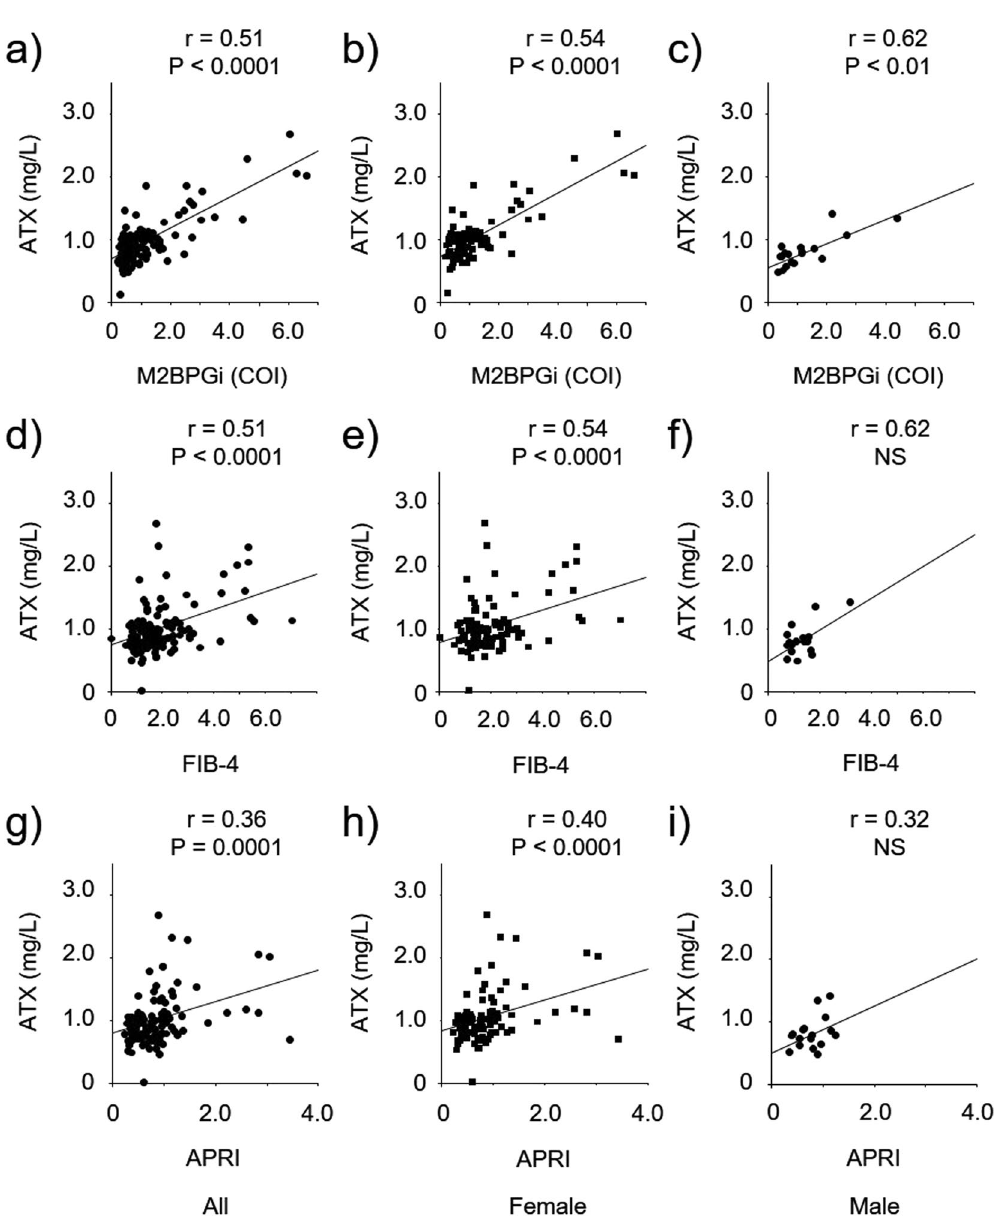
Figure 2. Correlation between ATX and other fibrosis markers, such as M2BPGi ( a – c ), FIB-4 ( d – f ), and APRI ( g – i ), in all, female, and male patients. Abbreviations: autotaxin, ATX; M2BPGi, Wisteria floribunda agglutinin- positive Mac-2-binding protein; FIB-4, fibrosis index based on four factors; APRI, aspartate aminotransferase- to-platelet ratio; NS, not